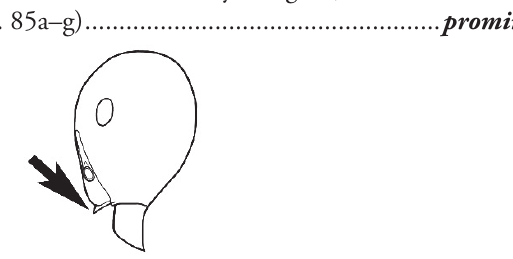
reduced to an angle in most cases); mandible of minor workers minutely striate with six or more teeth on masticatory margin (mid- and north-west